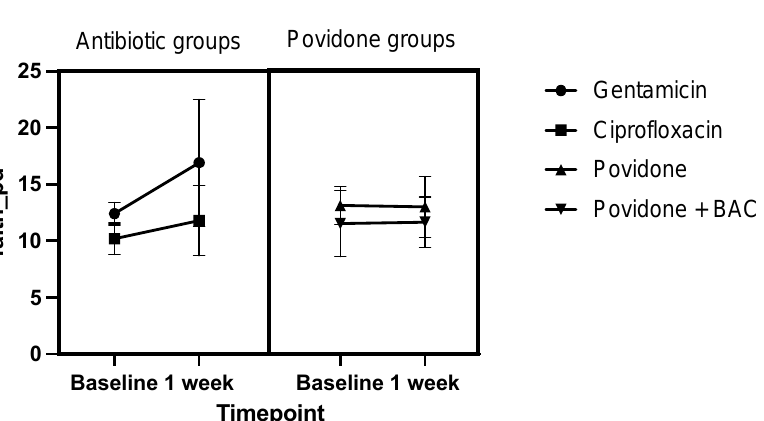
Figure 2. Faith_pd in nasal samples, meaning the sum of the branch lengths of a phylogenetic tree connecting all species in the target assemblage. Comparison of the phylogenetic diversity index be- fore and after treatment (Baseline: before instillation of eye drops, 1 week: after 7 days ’ instillation). Group 1 received gentamicin eye drops, group 2 received ciprofloxacin, group 3 received topical lubricants containing povidone only, group 4 received topical lubricants containing povidone and BAC.